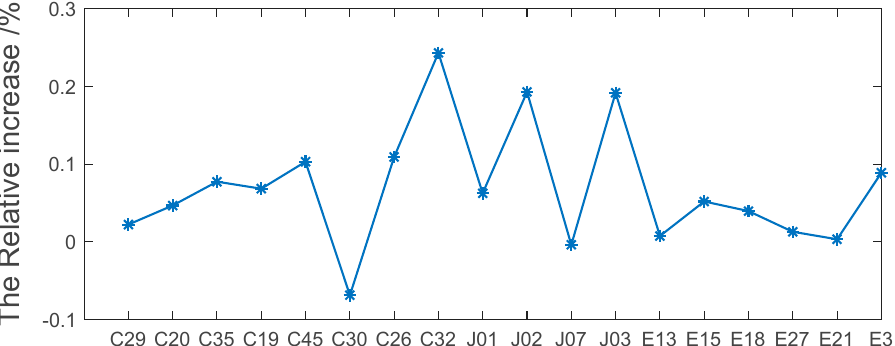
Figure 20. Relative increase in PLL discriminator output accuracy for MBOC signal.